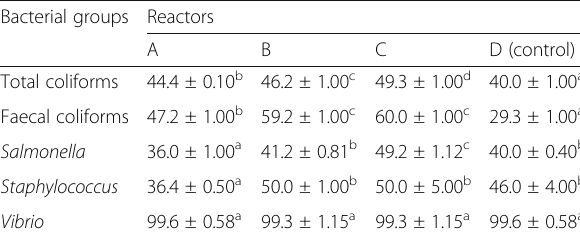
Table 3 Reduction ratios (%) of potential pathogens and indicator bacteria in digestate